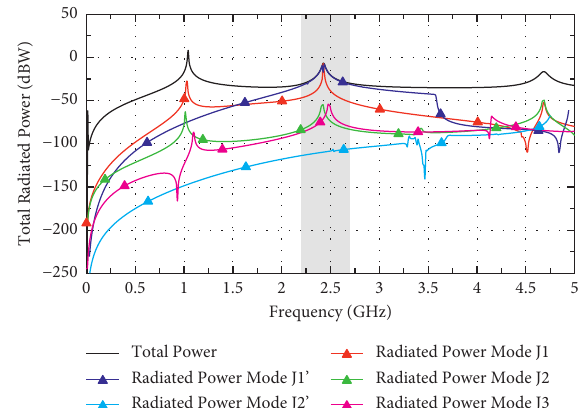
Figure 7: Total power and modal radiated power for two parallel plates with different sizes.